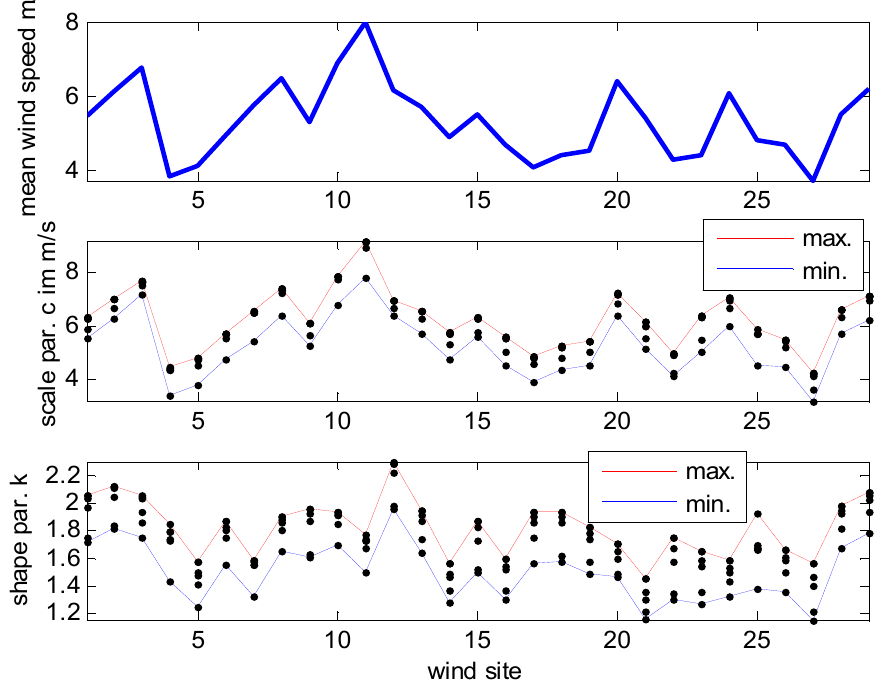
Figure 10. Representation of the error